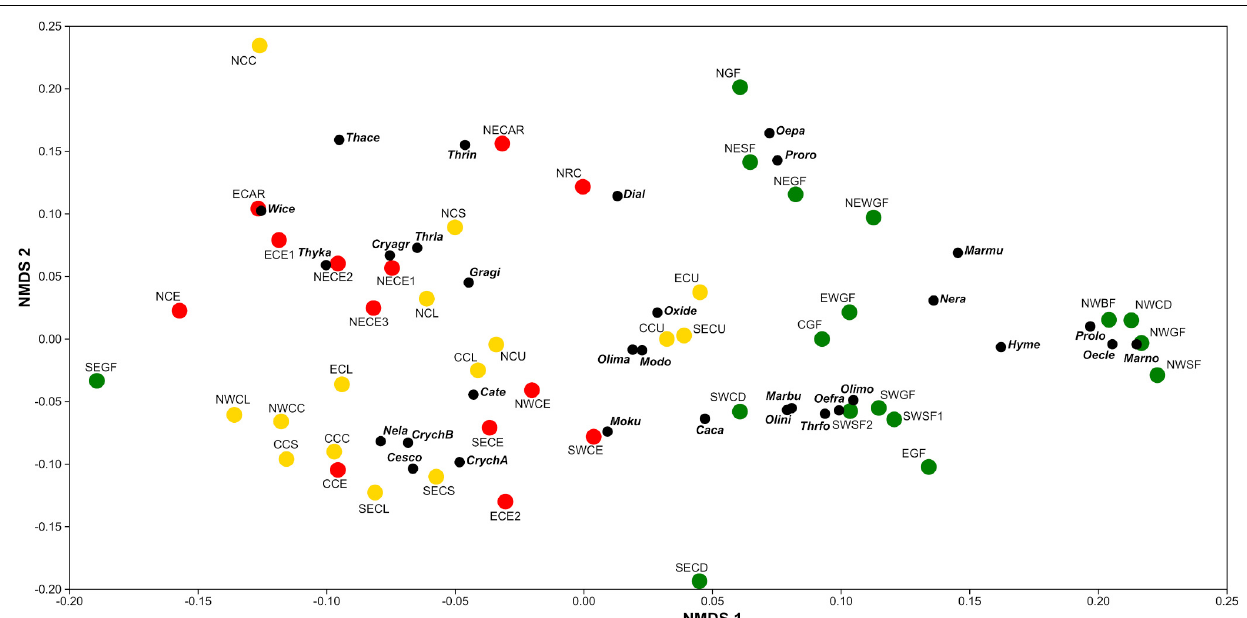
FIGURE 7 | A non-metric multidimensional scaling (NMDS) ordination plot based on a Bray–Curtis similarity matrix, considering the capture success of species with at least five captures across the 45 sites surveyed in the Cerrado. Sites in color, with forests represented by green circles, savannas by red circles, and grasslands by yellow circles. Black circles represent the species. Site acronyms are the junctions of localities and habitats, as follows: CENTRAL (C) = Área Alfa Cerrado Reserve, EAST (E) = Grande Sertão Veredas National Park, SOUTHEAST (SE) = Santa Bárbara Ecological Station, NORTHWEST (NW) = Serra das Araras Ecological Station, SOUTHWEST (SW) = Serra da Bodoquena National Park, NORTH (N) = Serra Geral do Tocantins Ecological Station, NORTHEAST (NE) = Uruçuí-Una Ecological Station, CU = “campo úmido,” CL = “campo limpo,” CS = “campo sujo,” CC = “campo cerrado,” CE = “cerrado sensu stricto, ” RC = “cerrado rupestre,” CAR = “carrasco,” CD = “cerradão,” GF = gallery forest, SF = seasonal forest, WGF = wet gallery forest, Species acronyms: Caca = Calomys callosus , Cate = Calomys tener , Cesco = Cerradomys scotti , Cryagr = Cryptonanus agricolai A, CrychA = Cryptonanus chacoensis A, CrychB = Cryptonanus chacoensis B, Dial = Didelphis albiventris, Gragi = Gracilinanus agilis , Hyme = Hylaeamys megacephalus , Marbu = Marmosa budini , Marmu = Marmosa murina , Marno = Marmosops noctivagus , Modo = Monodelphis domestica , Moku = Monodelphis kunsi , Nela = Necromys lasiurus , Nera = Nectomys rattus , Oecle = Oecomys cleberi , Oefra = Oecomys franciscorum , Oepa = Oecomys paricola , Olima = Oligoryzomys mattogrossae , Olimo = Oligoryzomys moojeni , Olini = Oligoryzomys nigripes , Oxide = Oxymycterus delator , Prolo = Proechimys longicaudatus , Proro = Proechimys roberti , Thace = Thalpomys cerradensis , Thrla = Thrichomys cf. laurentius , Thrfo = Thrichomys fosteri , Thrin = Thrichomys inermis , Thyka = Thylamys karimii , Wice = Wiedomys cerradensis